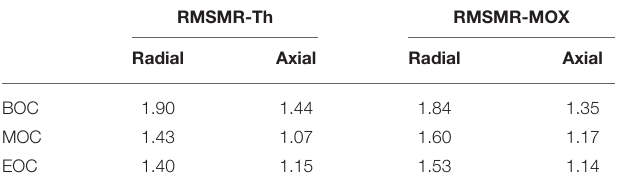
TABLE 1 | Power peaking factors.